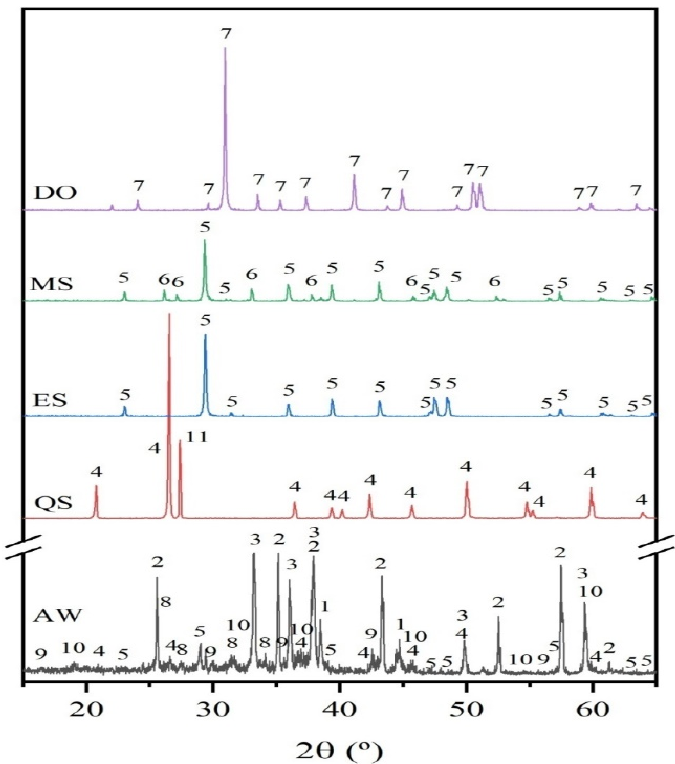
Figure 4. XRD patterns of raw materials: aluminum waste (AW), eggshells (ES), mussel shells (MS), dolomite (DO) and, quartz sand (QS) (1: Al, ICDD 00-004-0787; 2: Al 2 O 3 corundum, ICDD 00-046-1212; 3: AlN, ICDD 00-025-1133; 4: SiO 2 quartz, ICDD 01-083-0539; 5: CaCO 3 calcite, ICDD 00-005-0586; 6: CaCO 3 aragonite, ICDD 00-041-1475; 7: CaMg(CO 3 ) 2 dolomite, ICDD 01-089-5862; 8: K 4 H 4 Si 4 O 12 , ICDD 01-072-1101; 9: Fe 3 O 4 magnetite, ICDD 01-0075-1609; 10: Al 2 MgO 4 spinel, ICDD 01-073-2210; and, 11: KAlSi 3 O 8 microcline, ICDD